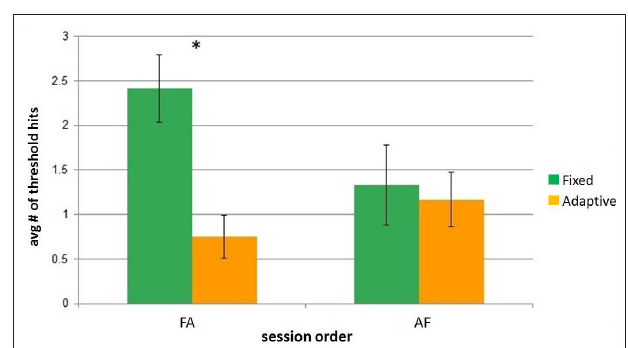
FIGURE 5 | Comparison of average amount of threshold hits per session and order group. Error bars represent standard error. Asterisks indicate significant